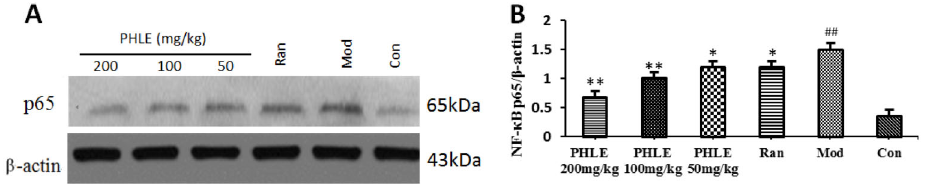
Figure 6. Effects of P. hydropiper extract (PHLE) on the total nuclear factor-kappa B (NF- k B) p65 level in the gastric tissues of rats with ethanol-induced gastric damage. A , Western blot analysis for protein expression of NF- k B p65; B , NF- k B p65/ b -actin ratio. The data are reported as means ± SD (n=10). ## P o 0.01 compared to the normal control group (Con); *P o 0.05 and **P o 0.01 compared to the model group (Mod) (ANOVA and LSD post hoc test). Ran: ranitidine (positive